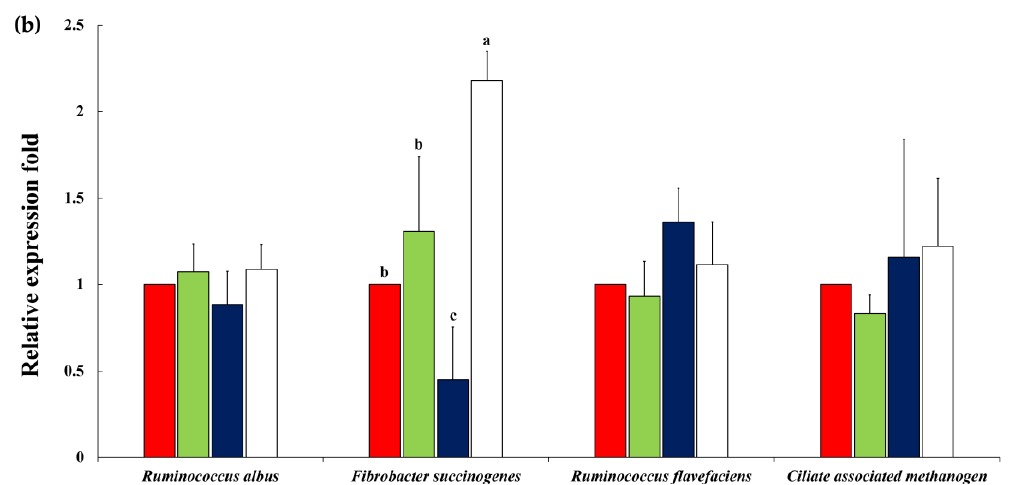
Figure 2. Relative quantification of in vitro rumen microbial population at ( a ) 12 h and ( b ) 24 h of incubation by Mentha canadensis . Error bars indicate the standard error of the mean ( n = 3). a–c Means with different superscript letters in the same row indicate significant differences ( p < 0.05). Table 6. E ff ect of Pinus densiflora and Mentha canadensis on abundances of bacteria, archaea and protozoa, in 12 and 24 h of in vitro incubation. p Value (3) Extract Concentration (1) (mg / L) Item SEM (2) 0